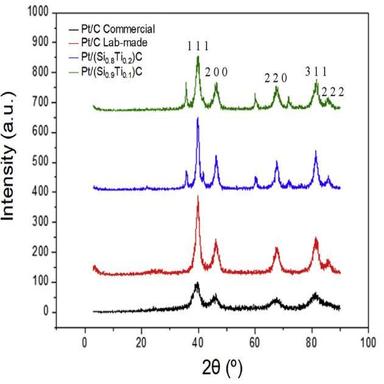
XRD patterns of the different prepared catalysts.